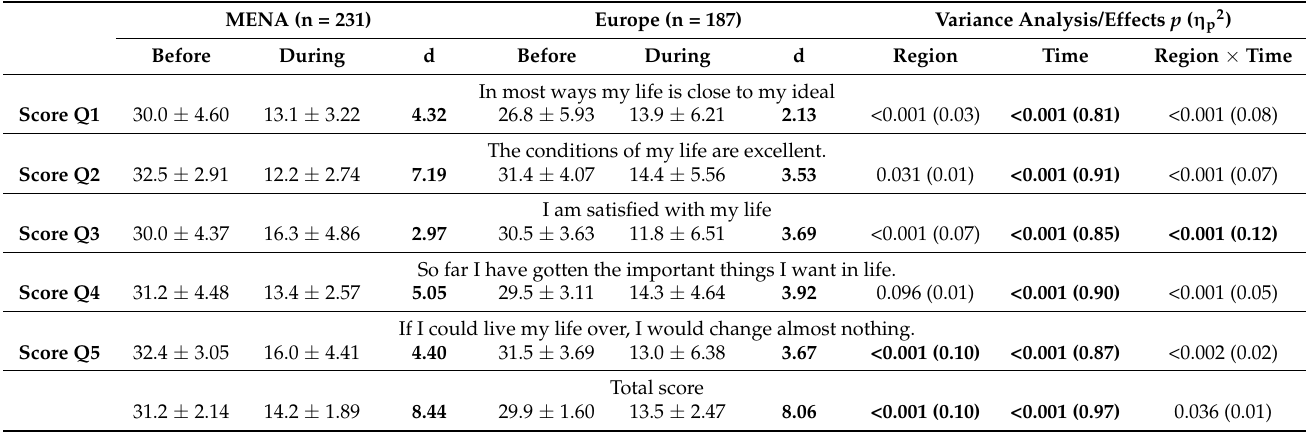
Table 4. Satisfaction with life parameters before and during confinement. Values are given as mean ± standard deviation. Meaningful effects are in bold